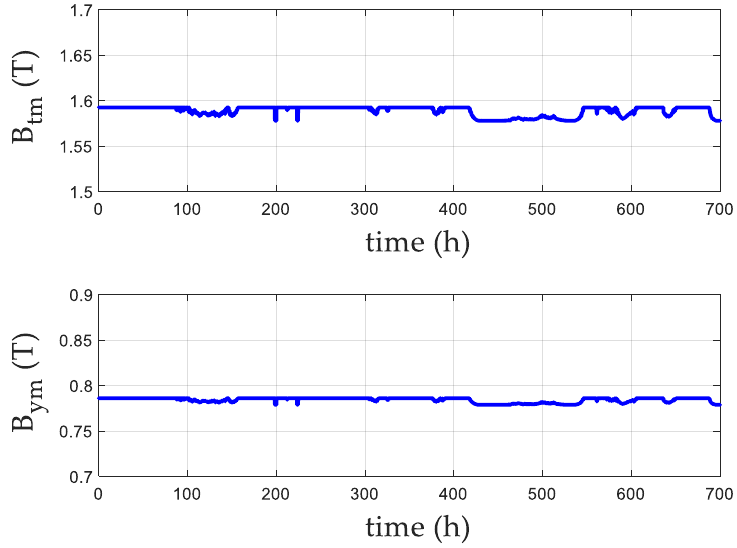
Figure 9. Evolution of the maximum flux density in tooth and yoke of the optimal generator.